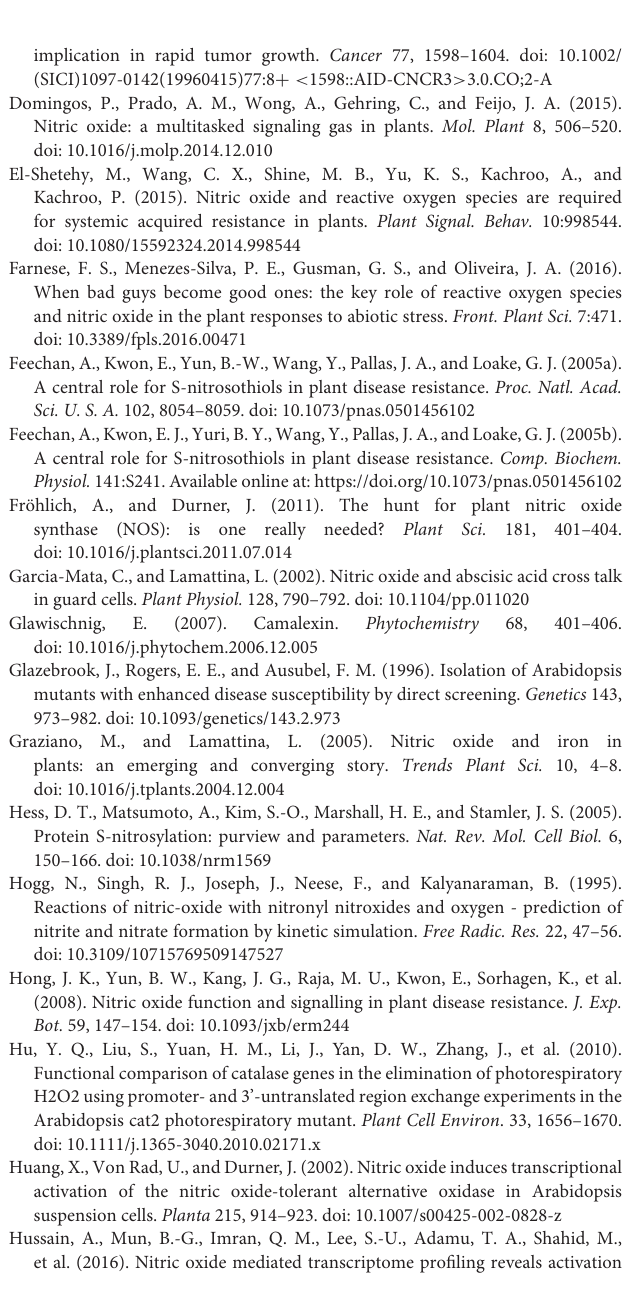
Supplementary Figure 2 | RTPCR confirmation for the abolishment of ILL6 expression in the ill6 T-DNA insertion mutant line.